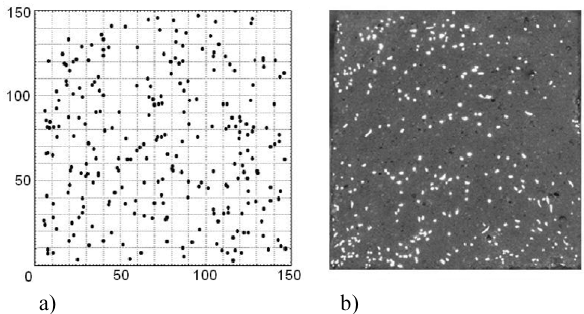
Fig. 6. The distribution of steel fibres in the composite crack failure cross-section: a) theoretical image; b) real image